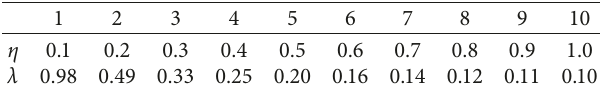
Table 1: Mechanical parameters of the Reid dampers used in the 10